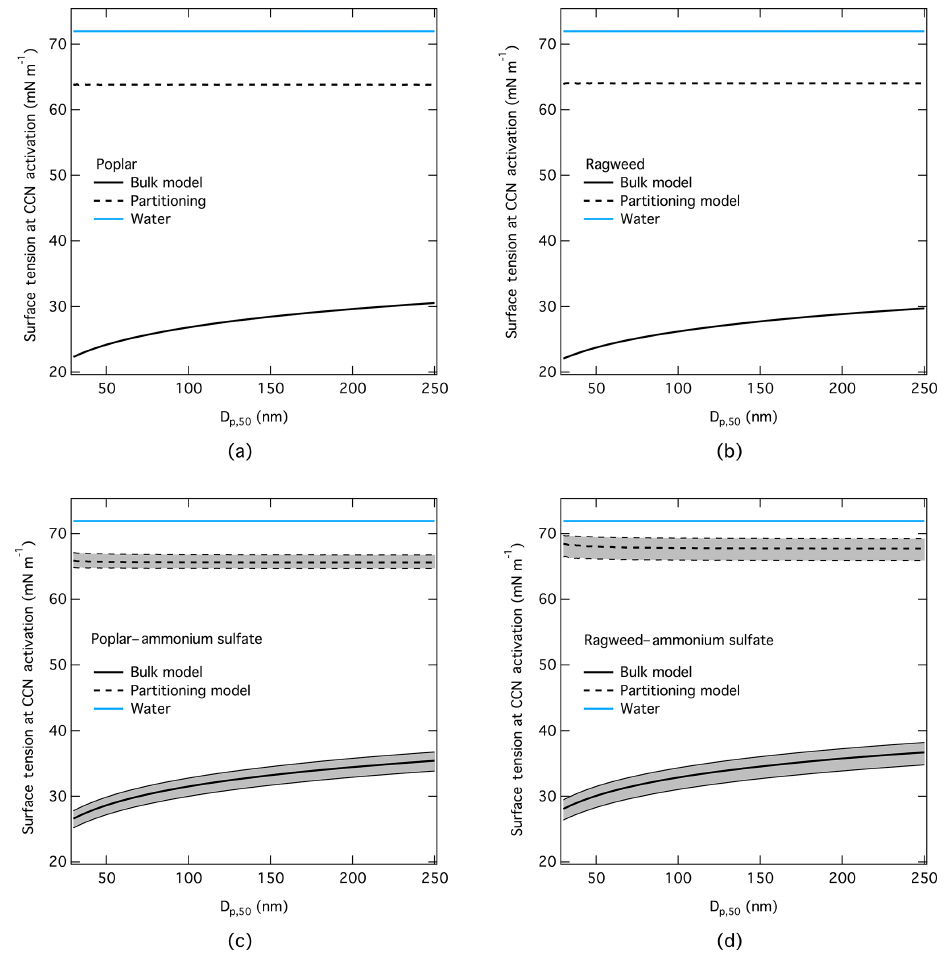
Figure 5. Droplet surface tension at the point of CCN activation modeled with the three different thermodynamic models (bulk, partitioning, and water) for particles comprising (a) pure poplar, (b) pure ragweed, (c) poplar and 20% by mass of ammonium sulfate, and (d) ragweed and 20% by mass of ammonium sulfate. For mixtures with ammonium sulfate, uncertainty ranges corresponding to a 10wt% uncertainty in dry particle composition are indicated for the bulk and partitioning models, which both include concentration-dependent surface